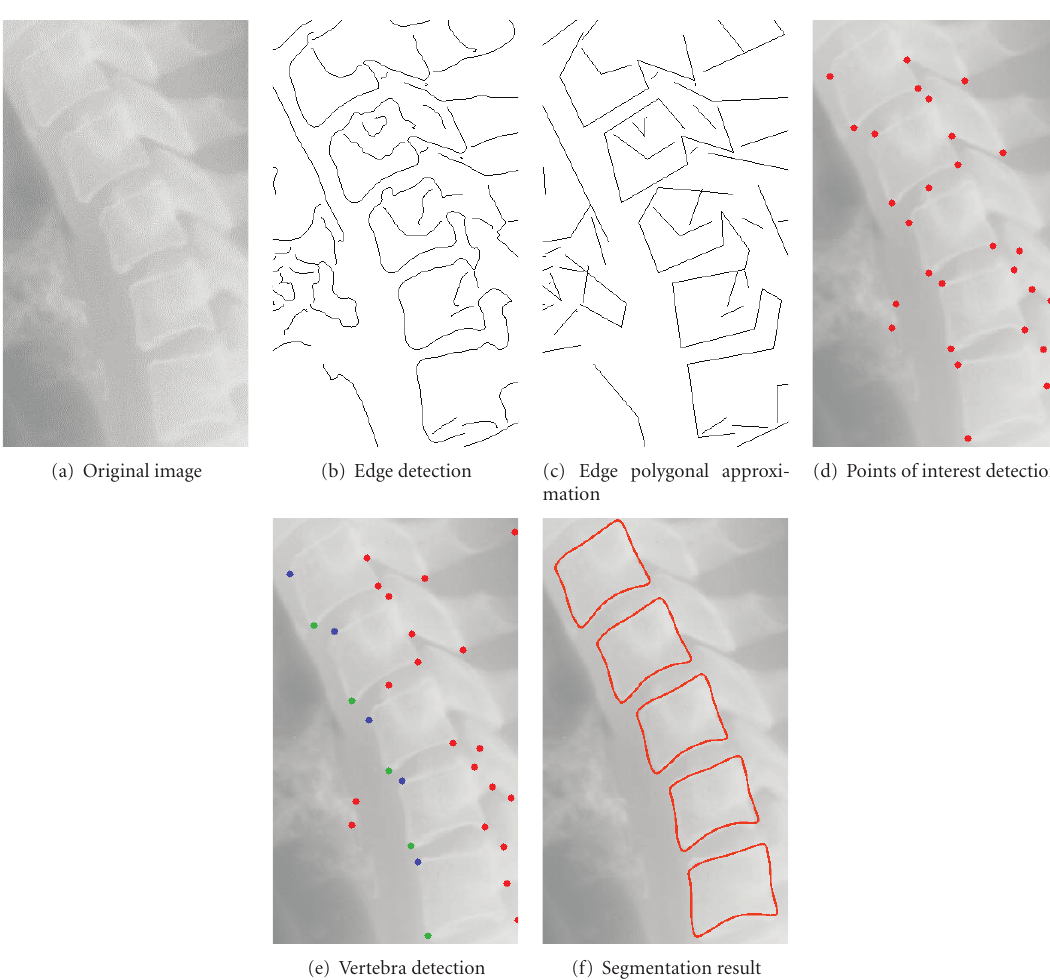
Figure 6: Illustration of the whole framework for the